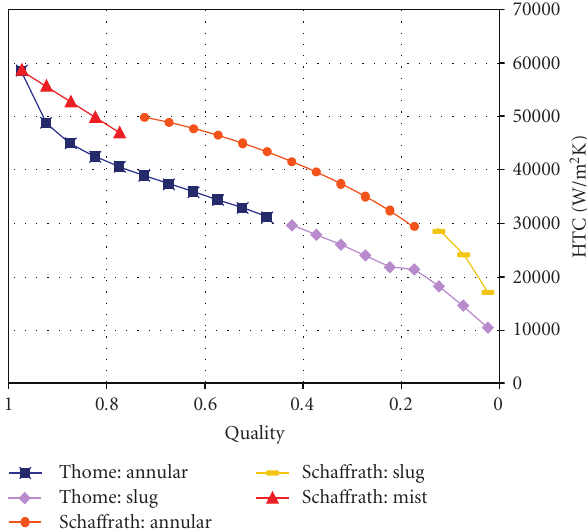
Figure 14: Comparison between Thome’s analysis and Scha ff rath’s analysis in stratified flow (G = 61.5 kg/sm 2 ).